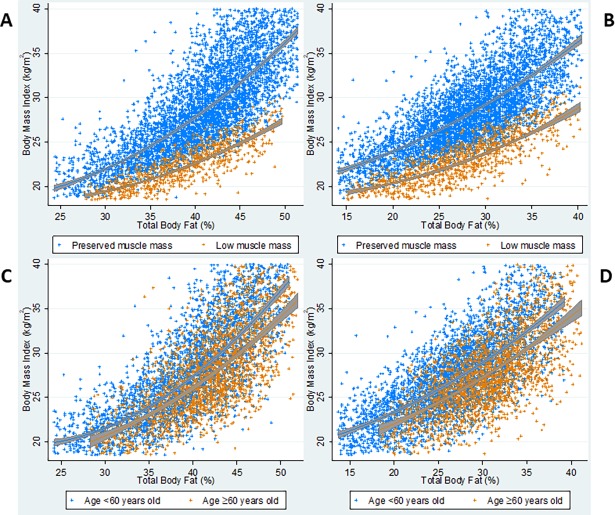
BMI versus total body fat percentage based on muscle mass status and age.Graphs show scatter plots of BMI and total body fat percentage and fitted b-splines based on muscle mass status for women (Panel A) and men (Panel B), and based on age <60 years or ≥60 years for women (Panel C) and men (Panel D). Scatter plots depict data for a single imputation but appeared identical for all imputations. B-splines were calculated using data from all imputations.